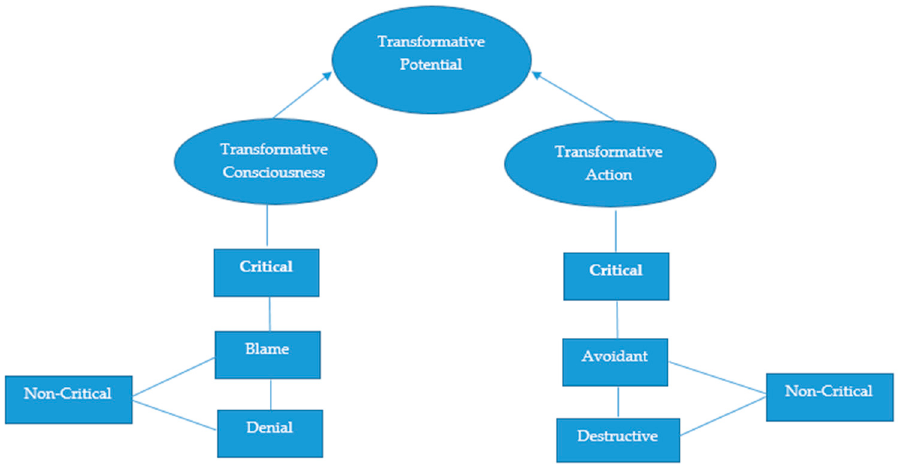
Figure 2. Levels of Transformative Consciousness and Transformative Action. Note. Figure 2 de- picts the two dimensions of Transformative Potential with the levels of the Transformative Con- sciousness and Transformative Action dimensions (Jemal